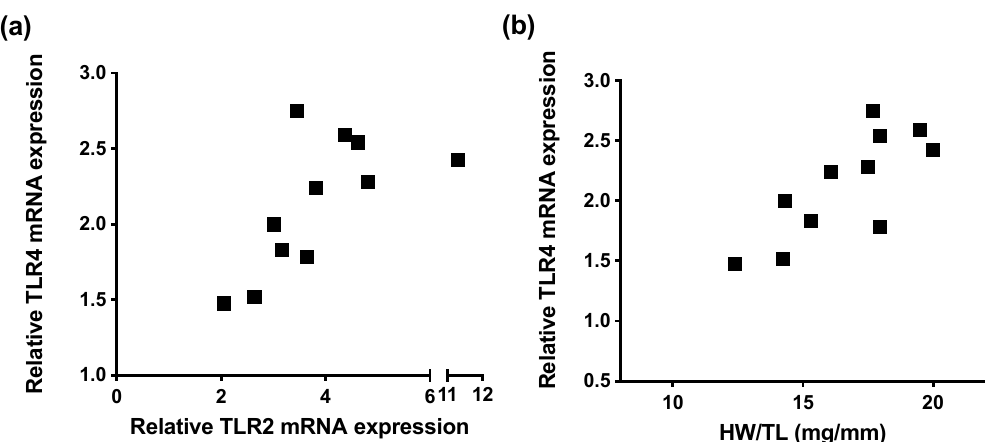
Figure 4. TLR4 and hypertrophy in mice upon chronic pressure overload. ( a ) Correlation between mRNA expression of TLR2 and TLR4 (r = 0.75; p = 0.01) assessed by TaqMan RT-qPCR in WT TAC mice in wildtype (WT) mice 12 weeks after transverse aortic constriction (TAC) surgery. ( b ) Correlation between heart weight to tibia length ratio (HW/TL, mg/mm) and ventricular mRNA expression of TLR4 (r = 0.78; p = 0.005). Correlations were analyzed using Pearson’s correlation.